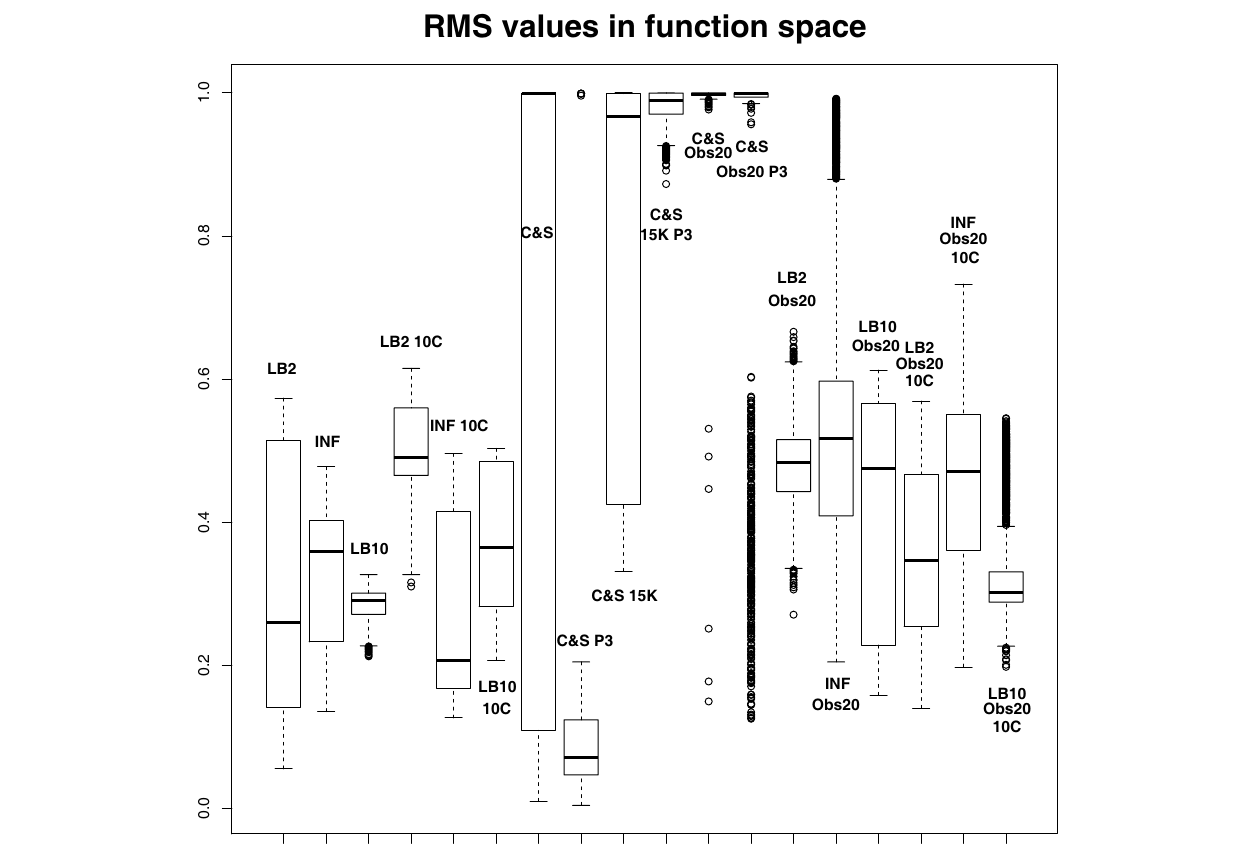
FIGURE 11 | Average posterior distributions of RMS values in function space, calculated on the residuals of the true signal (signal produced with true parameters and no observational error) minus the signal produced with the posterior sampled parameters . For viewing purposes, a squashing function has been applied to the RMS values, see equation (70). Larger values show poorer reconstructed signals. From left to right: LB2, INF, LB10, LB2 10C, INF 10C, LB10 10C, C&S, C&S P3, C&S 15K, C&S 15K P3, C&S Obs20, C&S Obs20 P3, LB2 Obs20, INF Obs20, LB10 Obs20, LB2 Obs20 10C, INF Obs20 10C, and LB10 Obs20 10C. For definitions, see Tables 3 and 4 . For an explanation of the boxplot form, see the beginning of Section